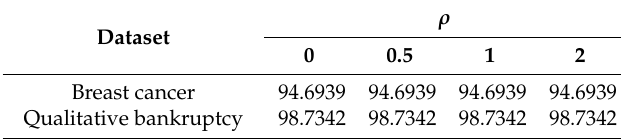
Table 4. Demonstration that varying ρ values have no effect on classification performance.